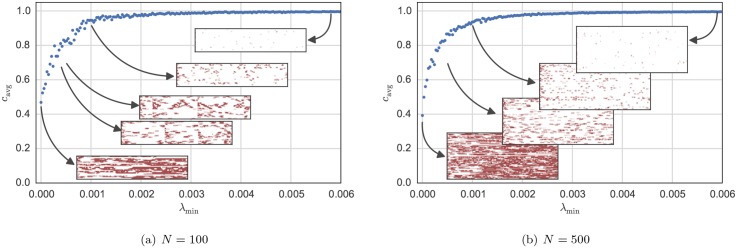
Influence of minimal gain λmin on system behavior for (a) N = 100 and (b) N = 500.Bigger minimum gains leads to more cooperation while smaller ones lead to defection. More complex behavior can be observed for values close to λmin = 0.0001 in mid sized systems. The systems parameters are RV = 2Ω, R0 = R/N = 200Ω, perr = 0.01 and V = 1 V. The communication network is configured as a ring.